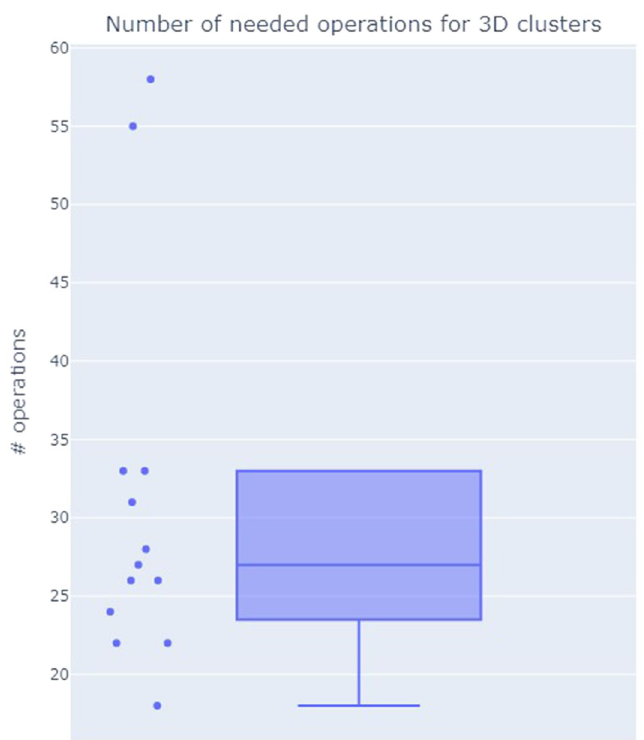
Fig. 7 Distribution of the convergence time in terms of the number of operations in the 3-D clustering